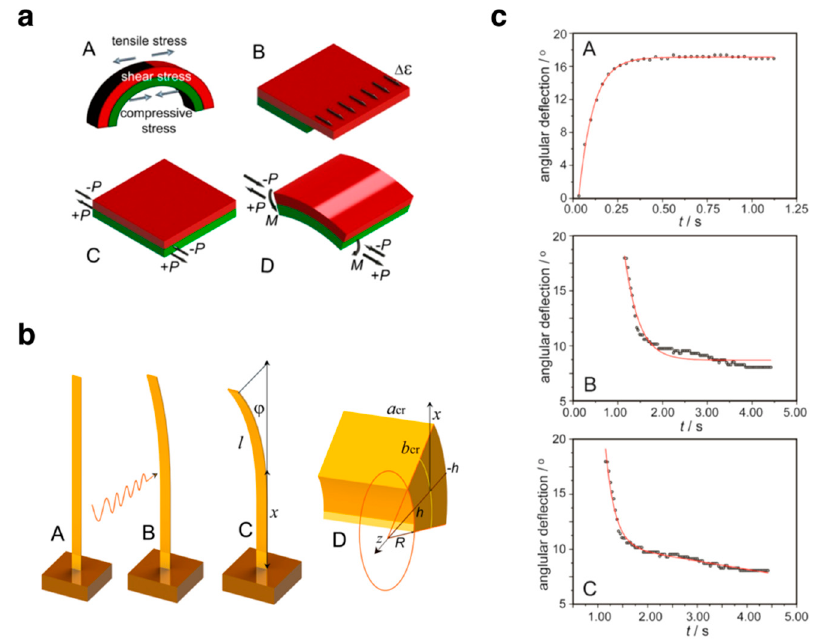
Figure 5. Model construction of the kinematic behavior of photo-bending. ( a ) Bilayer model of bending. ( b ) Definition of angular deflection and related parameters. ( c ) Model verification by reference to the experimental results of slender photomechanical crystals of trans - 8 . The models include a simple model for bending ( A ), a simple model for unbending ( B ), and an extended model for unbending ( C ). Reprinted with permission from [32]. Copyright 2014 American Chemical Society.